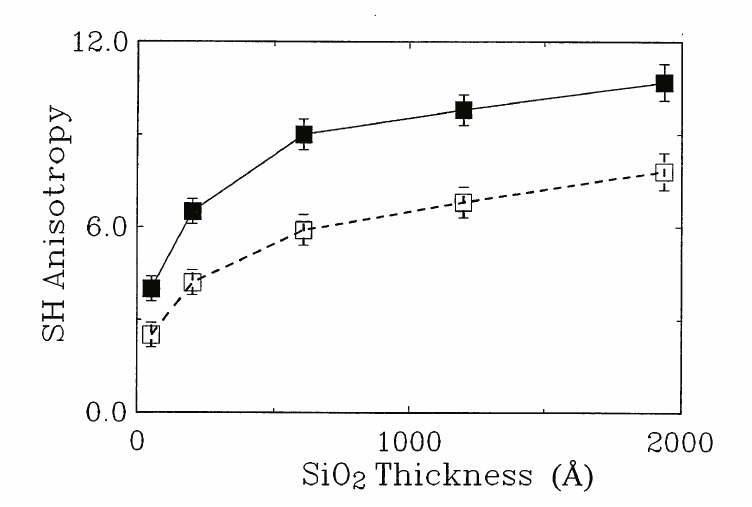
Figure 11. The angular components c azimuthal SH susceptibility in Equation 17 and 11, respectively versus the thickness of the silicon oxide layer on the silicon (111) substrate. Reproduced from Reference [39] with permission from the Japan Society of Applied